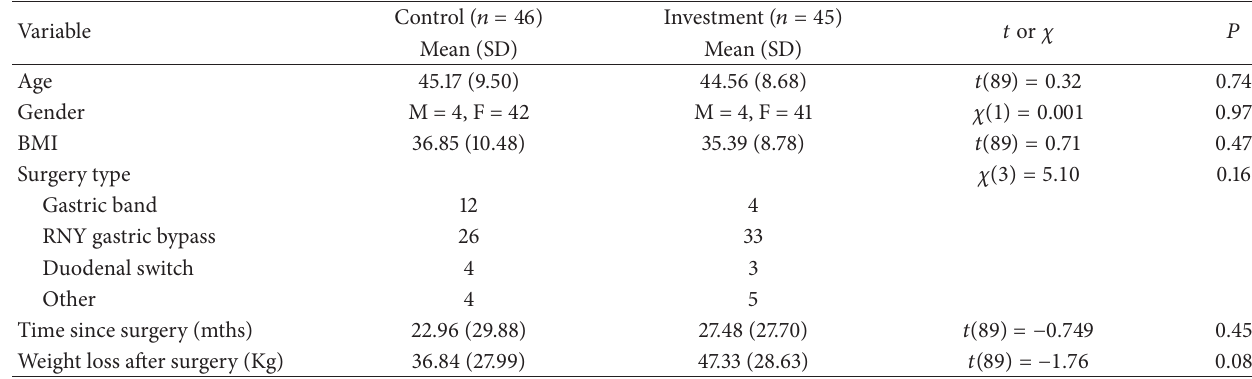
Table 1: Group characteristics of experimental conditions.